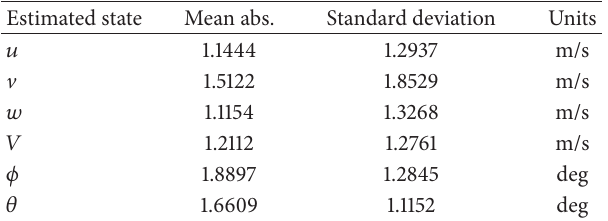
Table 7: Flight #2 error statistics for estimated states with range state.